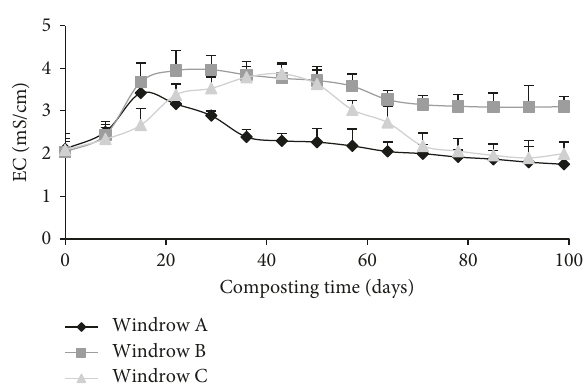
Figure 3: EC evolution during the composting process.